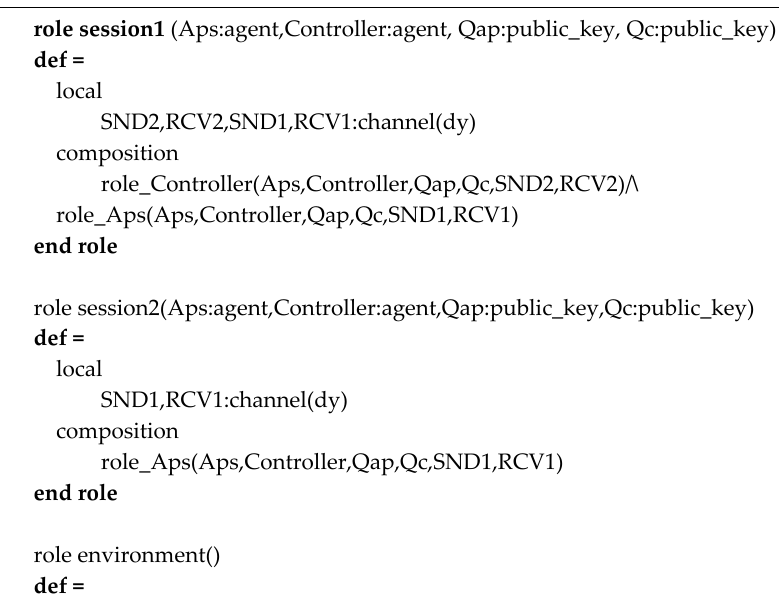
Algorithm A3 HLPSL code for session and environmental